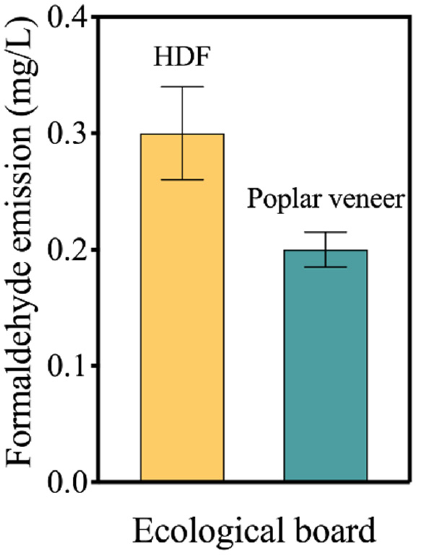
Figure 7. Formaldehyde emission of the impregnated paper decorated blockboard prepared with the two equilibrium layers.